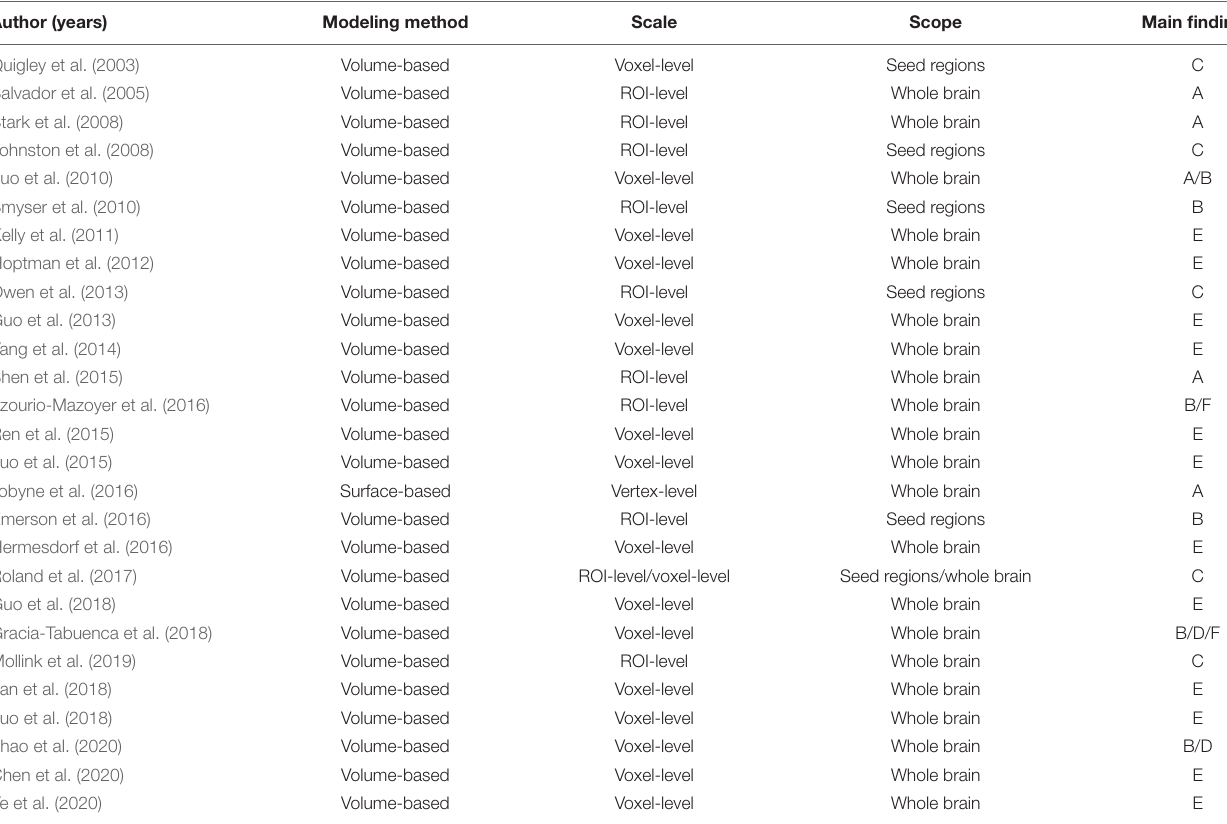
TABLE 1 | Basic information for published rs-fMRI studies of HoFC.